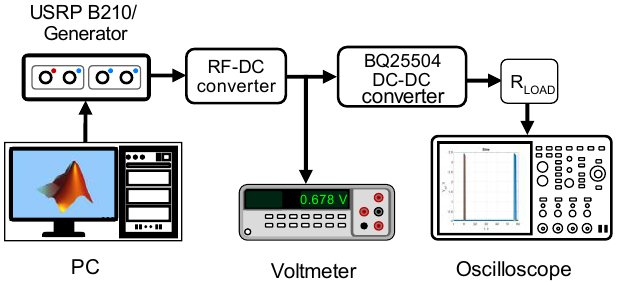
Fig. 4. Test setup for the RF-DC-DC conversion measurements in wired testing